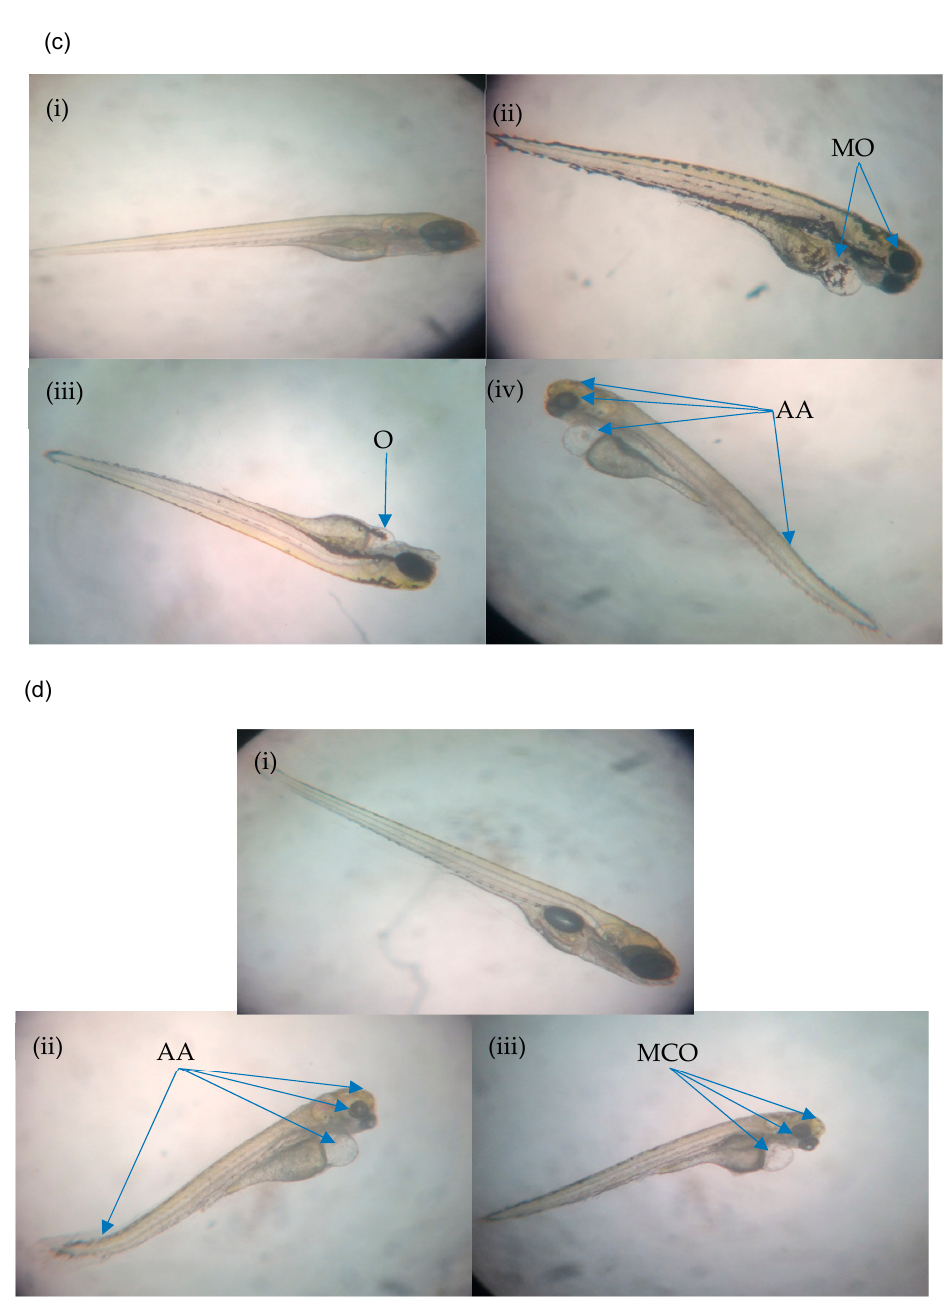
Figure 4. ( a ) Normal and abnormal zebrafish embryos at 24 h post-irradiation. ( a (i)) negative control (normal development); ( a (ii)) abnormal morphology in IN and IKH groups (microphthalmia); ( a (iii)) abnormal morphology in IN group (body curvature with microphthalmia); ( a (iv)) abnormal morphology in IA group (body curvature with microphthalmia and microcephaly). ( b ) Normal and abnormal zebrafish embryos at 48 h post-irradiation. ( b (i)) Negative control (normal development); ( b (ii)) abnormal morphology in IN and IKH groups (microphthalmia with pericardial oedema); ( b (iii)) abnormal morphology in IN group (body curvature with microphthalmia); ( b (iv)) abnormal morphology in IA group (body curvature with microphthalmia and microcephaly). ( c ) Normal and abnormal zebrafish embryos at 72 h post-irradiation; ( c (i)) negative control (normal development); ( c (ii)) abnormal morphology in IN group (microphthalmia with pericardial oedema); ( c (iii)) abnormal morphology in IKH group (pericardial oedema); ( c (iv)) abnormal morphology in IN, IKH and IA group (body curvature with microphthalmia, microcephaly and pericardial oedema). ( d ) Normal and abnormal zebrafish embryos at 96 h post-irradiation; ( d (i)) Negative control (normal development); ( d (ii)) abnormal morphology in IN and IKH group (body curvature with microphthalmia, microcephaly and pericardial oedema); ( d (iii)) abnormal morphology in IKH and IA group (microphthalmia with microcephaly and pericardial